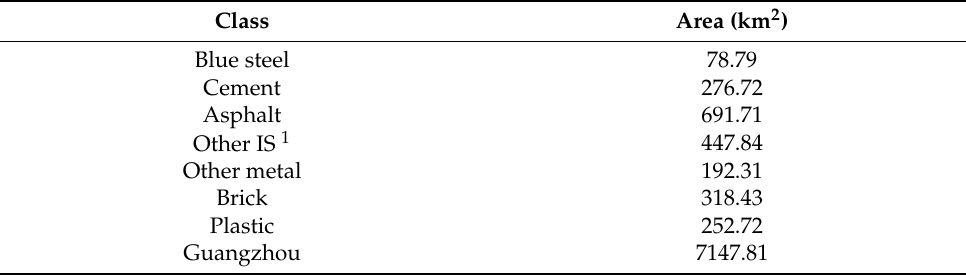
Table 2. Area of each class in Guangzhou.